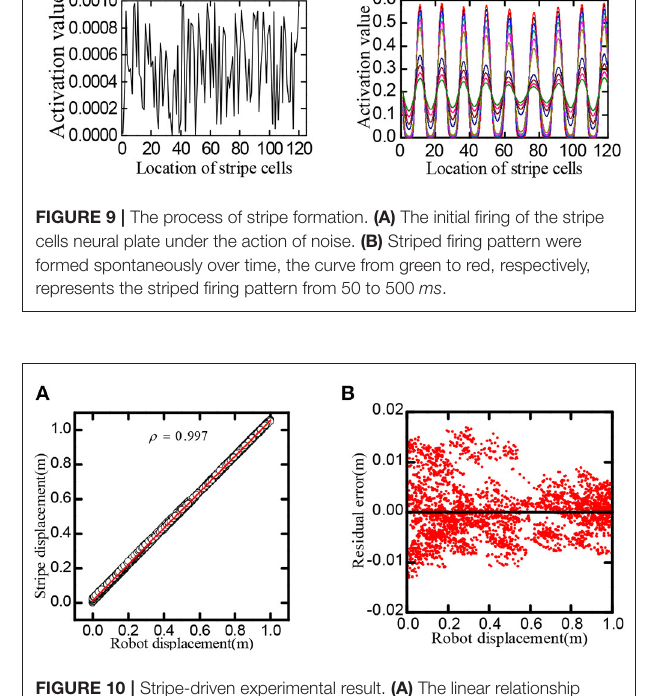
FIGURE 10 | Stripe-driven experimental result. (A) The linear relationship between the position and the phase movement of the stripe. (B) The direct residual of the stripe cells on cognitive position and regression line.